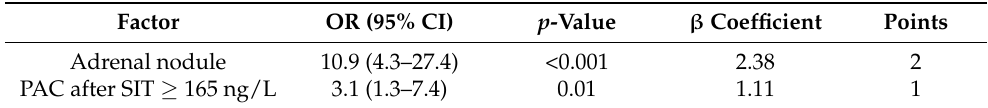
Table 4. Significant factors for the prediction of unilateral